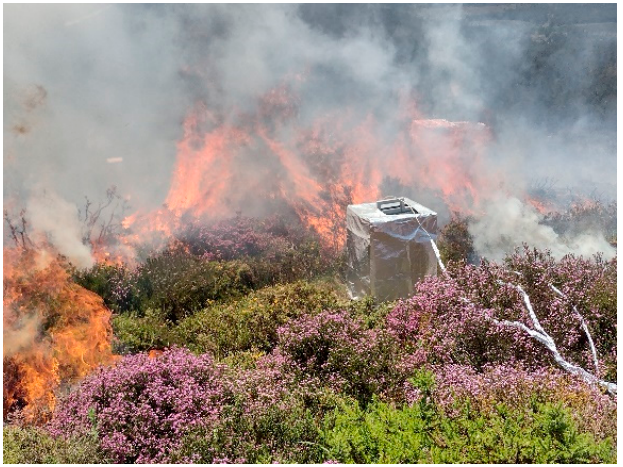
Figure 2. Field test (PSS) views during the arrival of the fire front at the protective device of the gas cylinder.